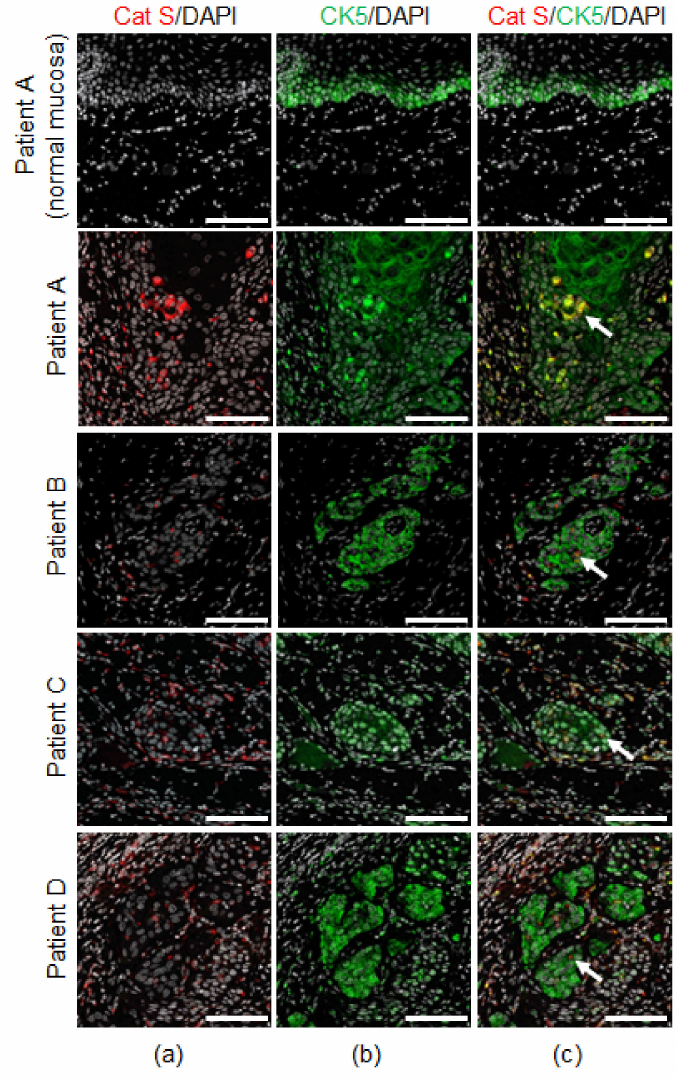
Figure 3. Localization of cathepsin S expression in human oral cancer cells. The immunofluorescent staining of four patients with oral SCC, and adjacent normal tongue tissue section from one of the patients with oral SCC (Table 2). ( a ) Co-immunofluorescent staining of cathepsin S (Cat S, red) and DAPI (gray); ( b ) cytokeratin for SCC cells (CK5, green) and DAPI (gray); ( c ) Cat S (red), CK5 (green) and DAPI (gray). White arrows indicate cathepsin S in SCC cells. Scale bars, 100 µ